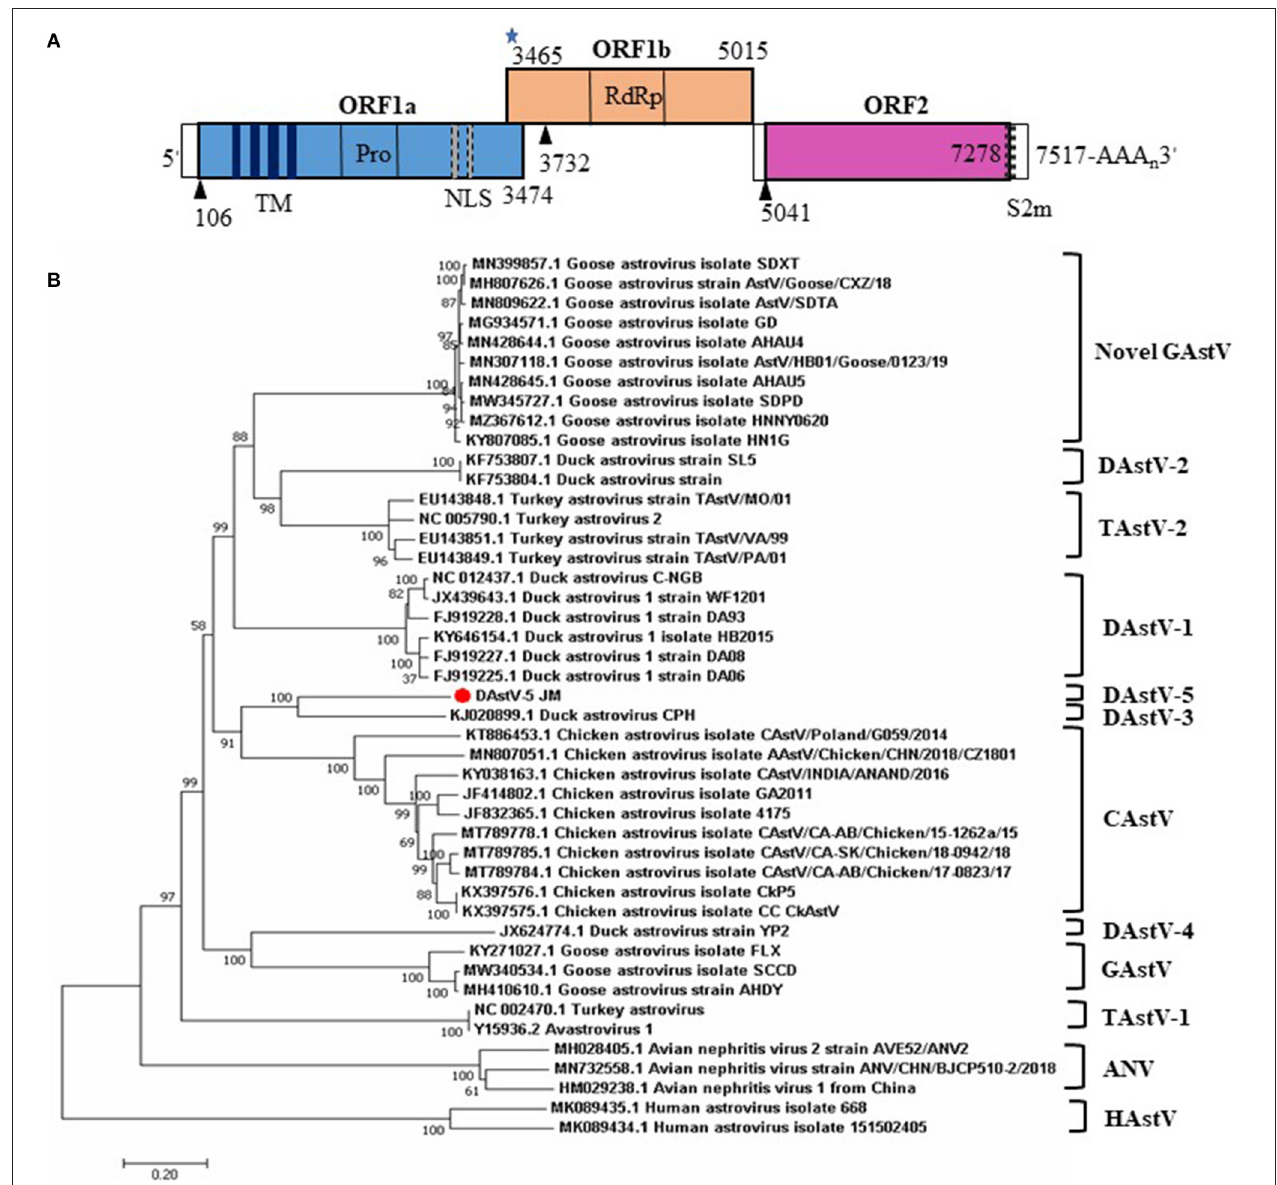
FIGURE 2 | Genome organization and phylogenetic analysis of the complete genome sequences of DAstV-5 JM strain. (A) The three predicted ORFs and the typical genomic characteristics are shown. The black triangles represent the translation start site of the three ORFs. The blue star represents the heptameric AAAAAAC sequence. (B) The phylogenetic tree was constructed using MEGA 7.0 software using the neighbor-joining method, with 1,000 bootstrap replications. ANV, avian nephritis virus; CAstV, chicken astrovirus; DAstV, duck astrovirus; GAstV, goose astrovirus; HAstV, human astrovirus; TAstV, turkey